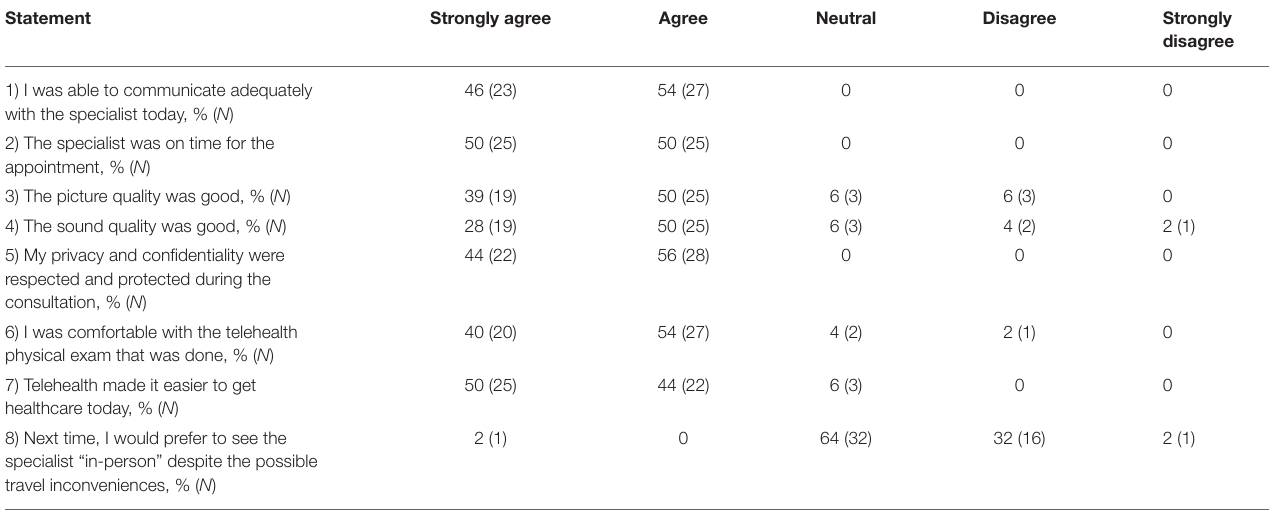
TABLE 2 | Utah Telehealth Survey Responses by neuromuscular patients.